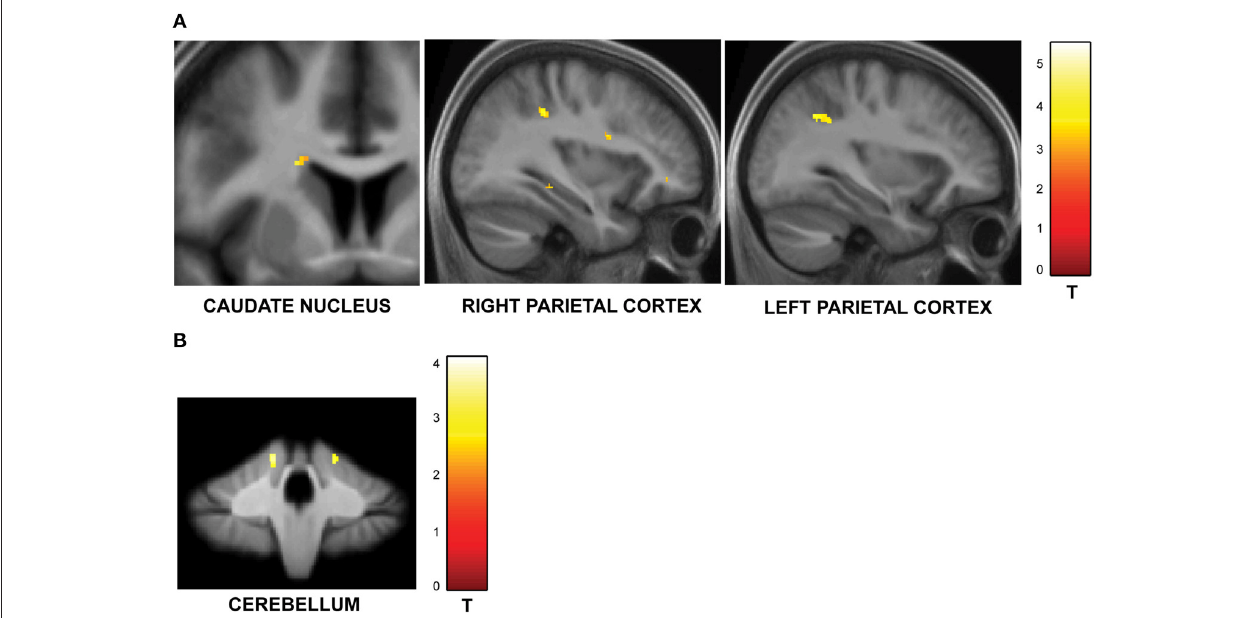
FIGURE 3 | Functional imaging results: effect of number of intervals. (A) Brain areas that encode temporal memory as a function of increasing number of intervals. The activity in the caudate and the inferior parietal cortex was found to increase parametrically with the number of intervals. The MNI coordinates of these areas are listed in Table 2A . (B) Brain areas that encode temporal memory as a function of decreasing number of intervals. BOLD responses in the cerebellum was found to vary as a function of decreasing number of intervals. The MNI coordinates are provided in Table 2B .